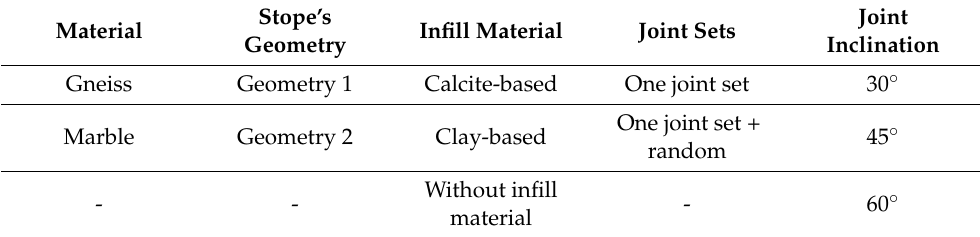
Table 3. Categories of simulation